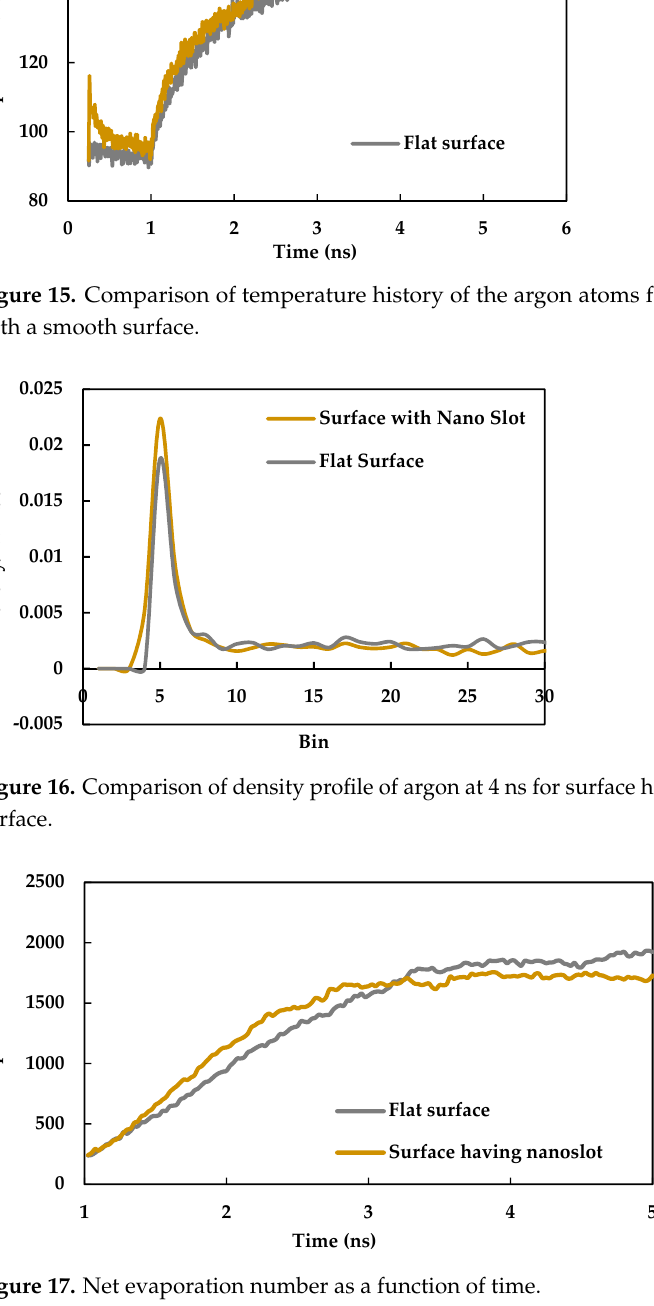
Figure 17. Net evaporation number as a function of time.